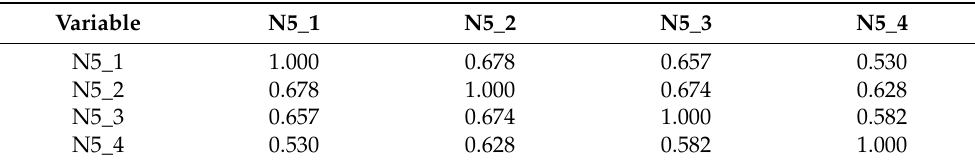
Table 6. Correlation matrix for acceptance of PwD types 1 .